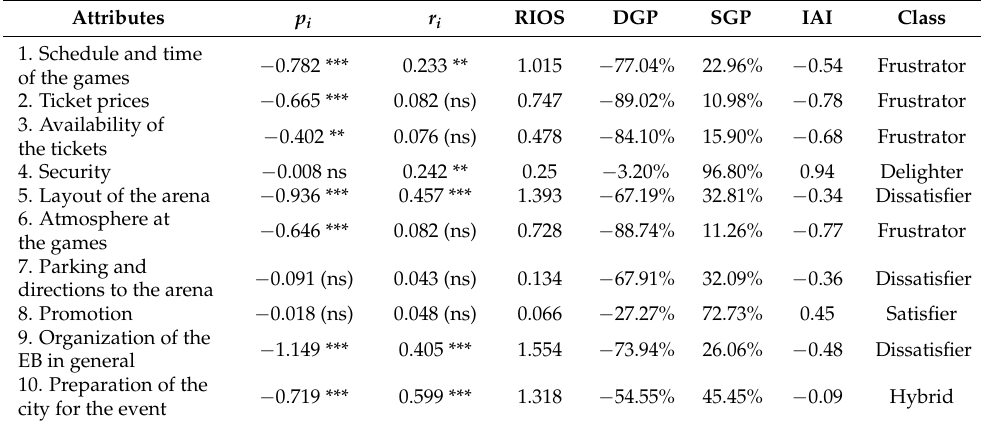
Table 3. The results of the IA analysis.